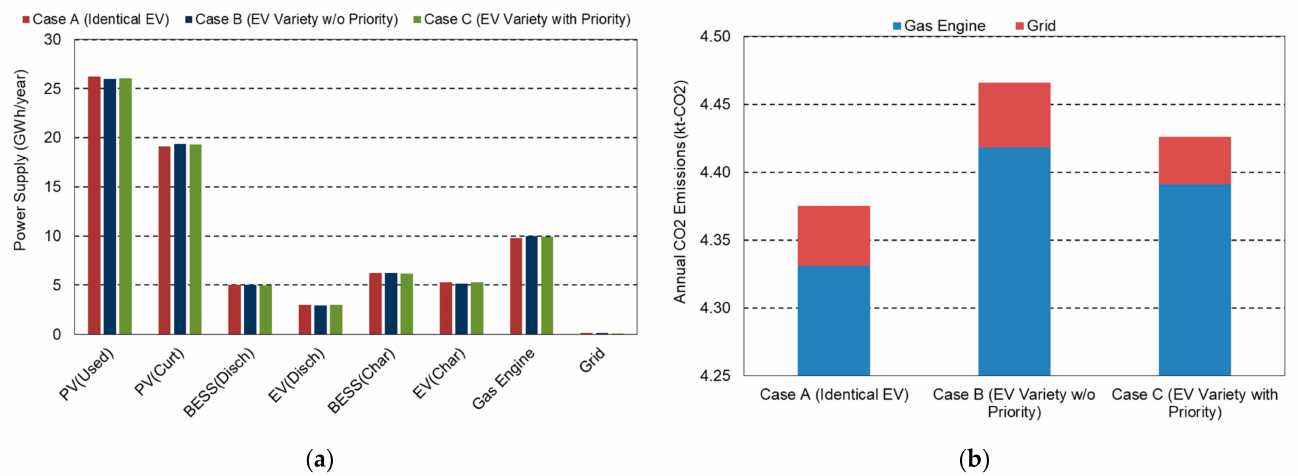
Figure 13. Annual power system simulation results (TED model): ( a ) power generation mix and ( b ) CO 2